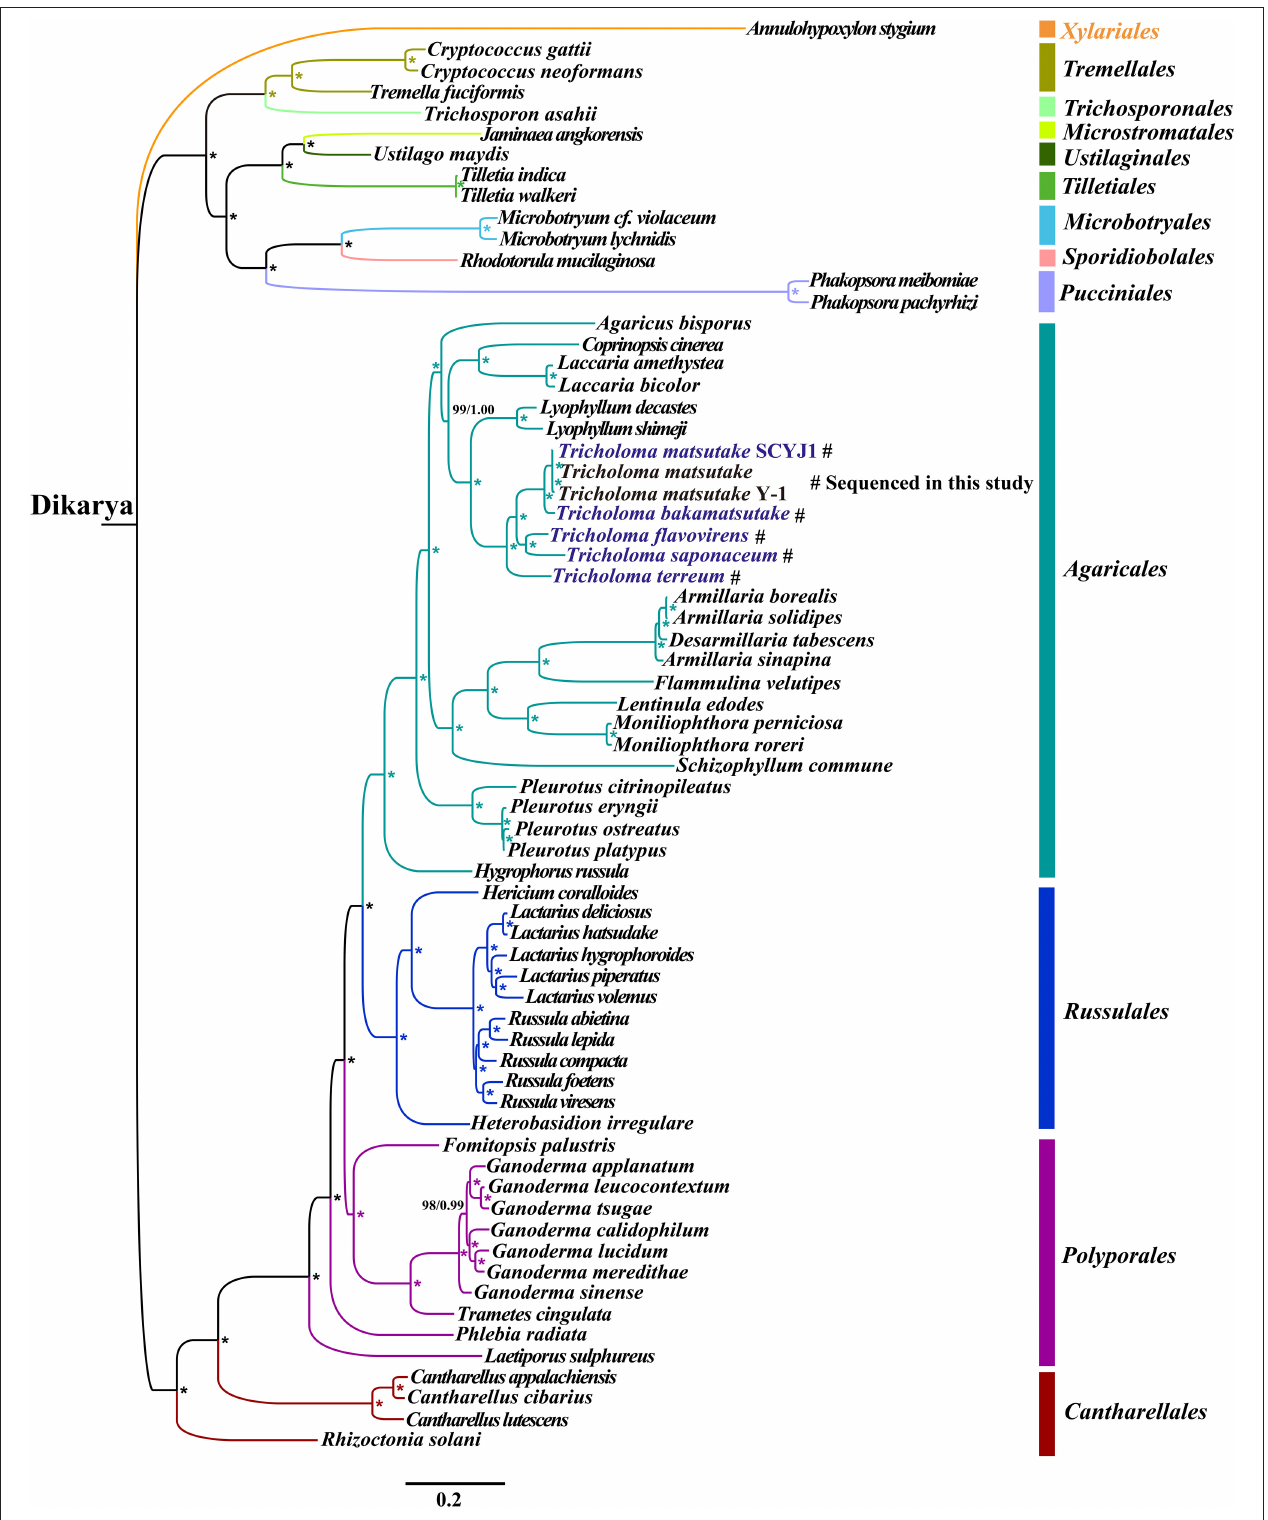
FIGURE 8 | Molecular phylogeny of 67 Basidiomycota species based on Bayesian inference (BI) and maximum likelihood (ML) analysis of 15 protein-coding genes. Support values are Bayesian posterior probabilities (BPP; before slash) and bootstrap (BS) values. The asterisk indicates that the BS and BPP values on the evolutionary branch are 100 and 1.00, respectively. Species and NCBI accession numbers for genomes used in the phylogenetic analysis are provided in Supplementary Table 9 .